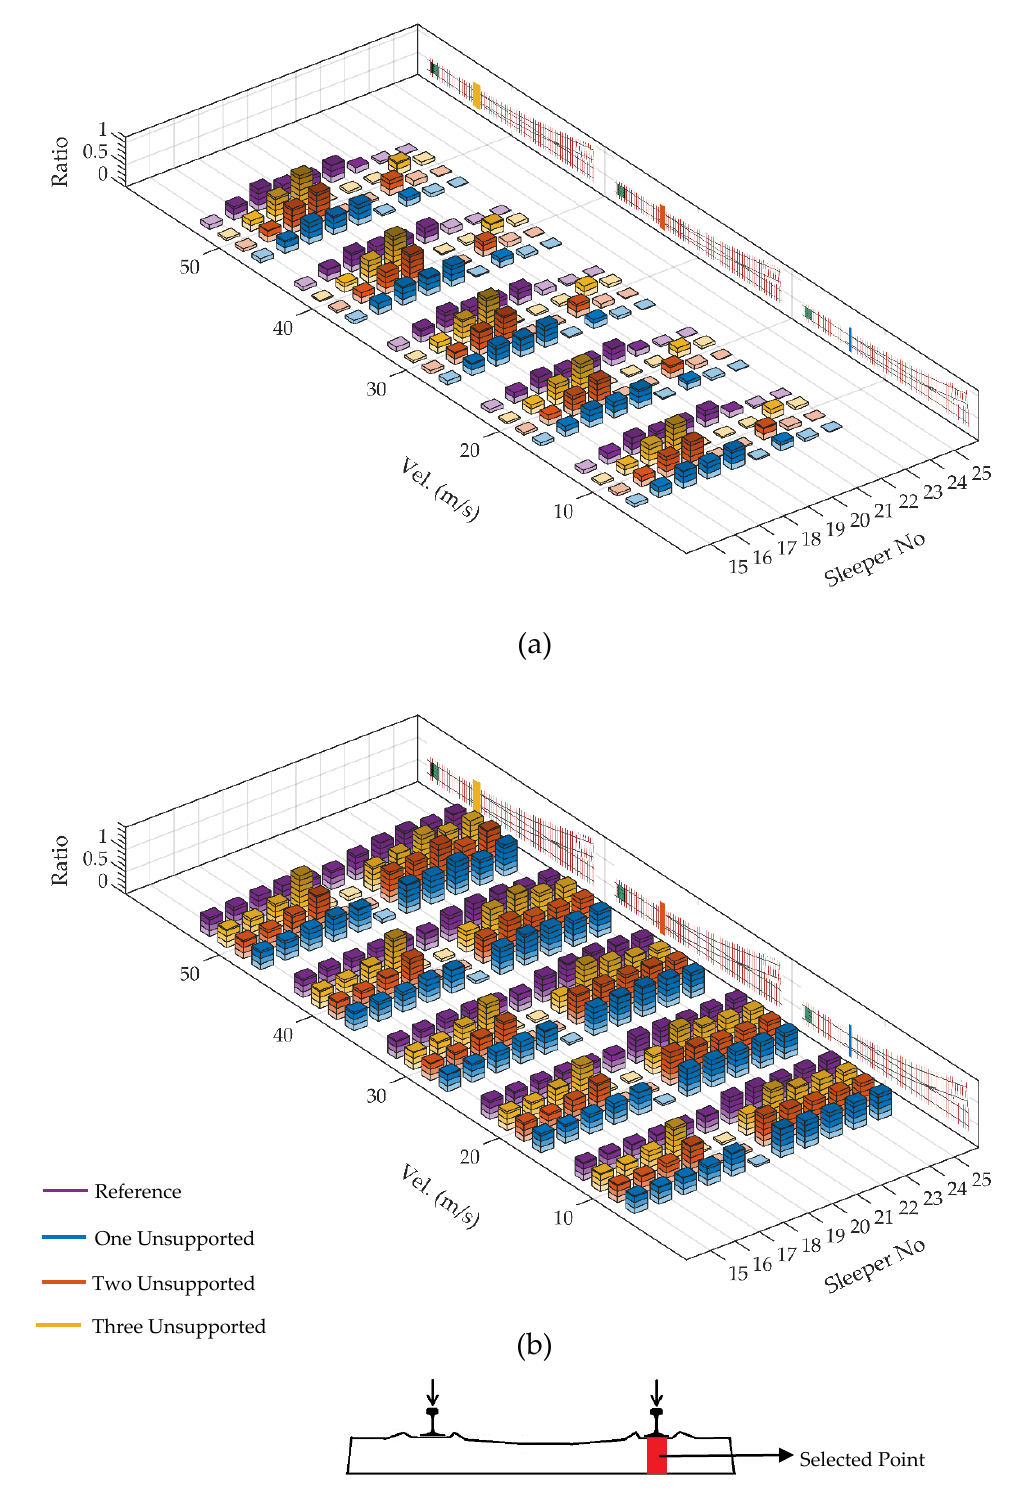
Figure 11. The distribution of rail seat force over the bearers when unsupported bearers exist under switchblades: ( a ) at a particular time when the front wheel is on the bearer with number 20; ( b ) when maximum occurs at each bearer.